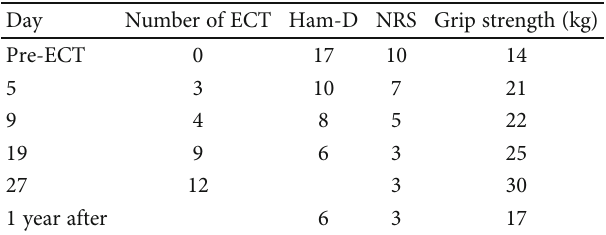
Table 1: The course of symptoms after ECT. Day Number of ECT Ham-D NRS Grip strength